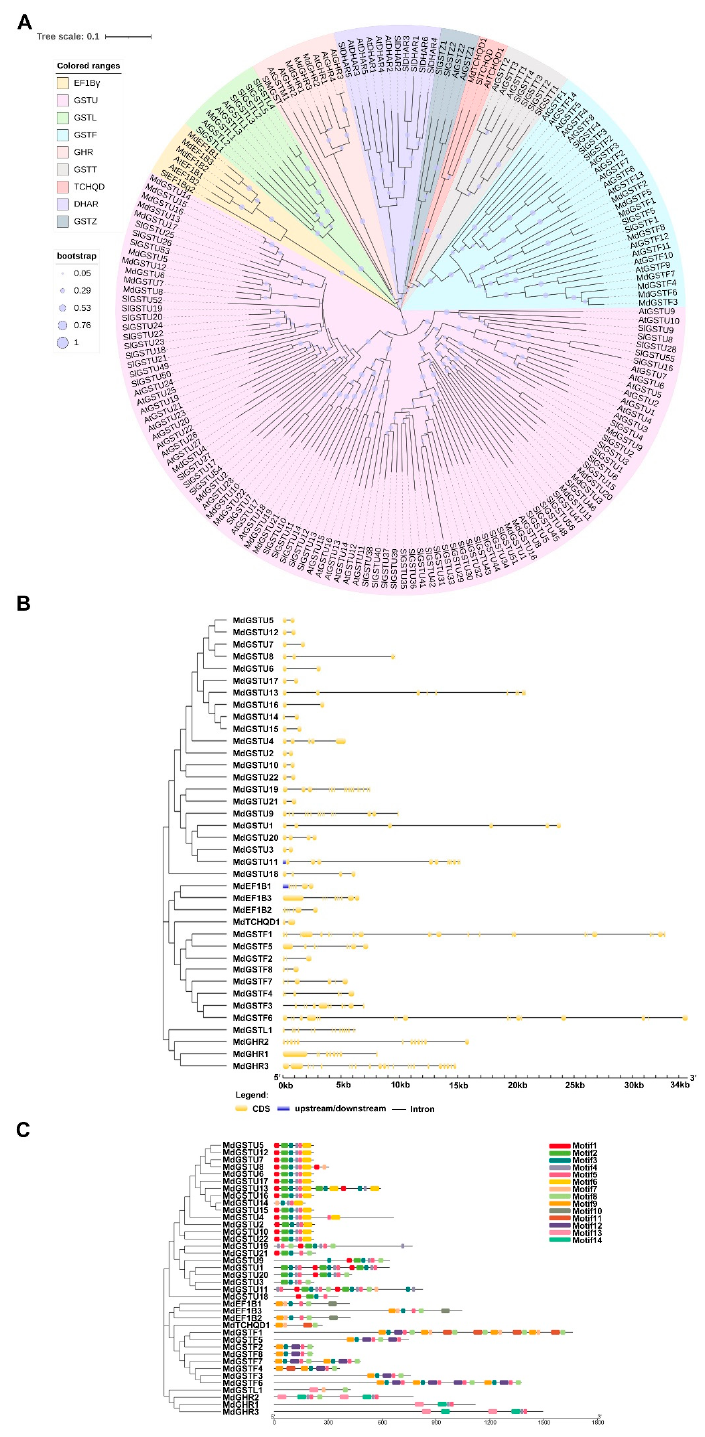
Figure 1. Phylogenetic analysis, gene structure, and motif analysis of the MdGSTs. ( A ) The phyloge- netic analysis of GST family genes of Arabidopsis , apple, and tomato. The tree was constructed via the maximum likelihood method with 1000 bootstrap replications. A neighbor-joining tree was generated by MEGA X software, and the tree was annotated using Interactive Tree Of Life (iTOL). The solid line represents the real branch length, and the dotted lines were added later for better visualization. ( B ) Exon-intron structure analysis of MdGST genes. The exons and introns are represented by yellow boxes and black lines, respectively. ( C ) Conserved domains of the MdGSTs, represented by colored